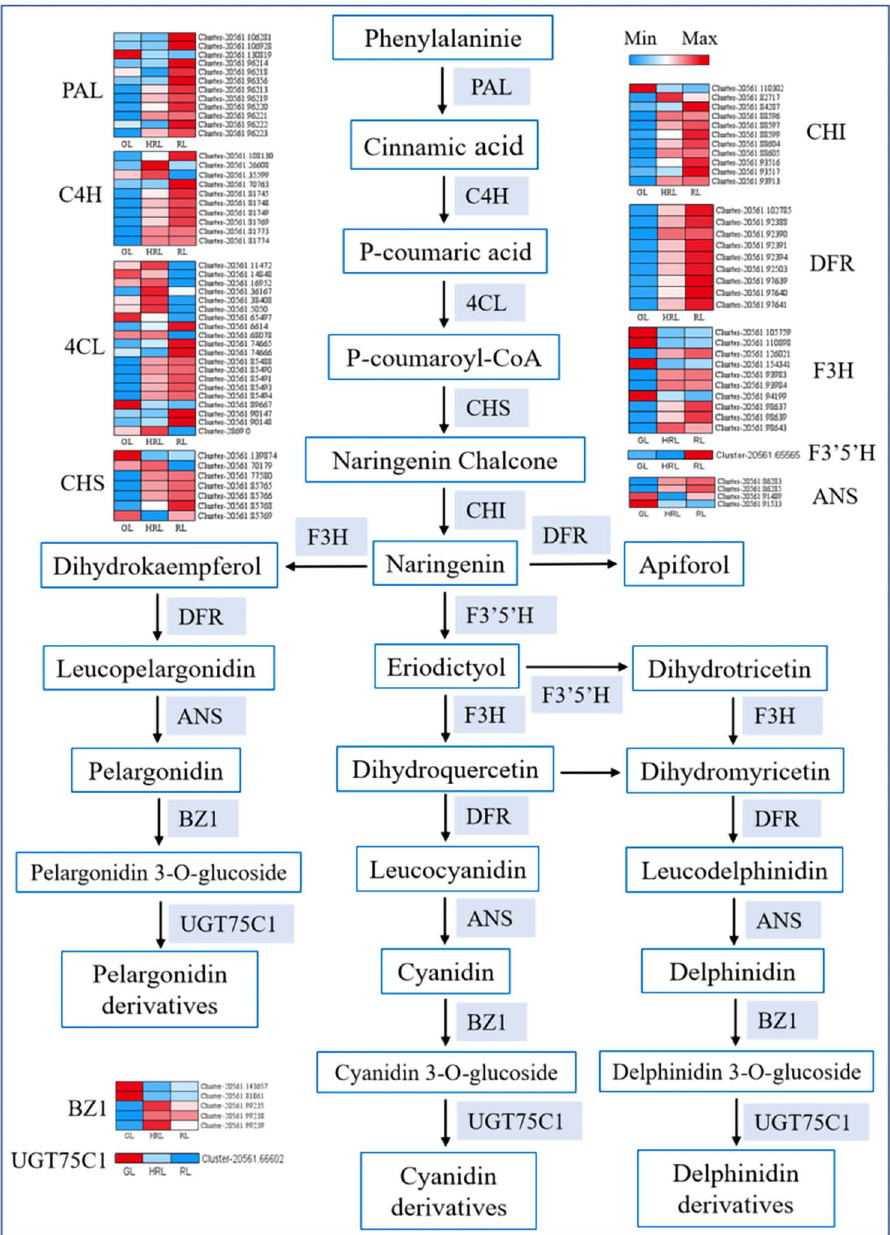
Figure 6. Modulation of phenylpropanoid, flavonoid, and anthocyanidin biosynthesis pathway genes during leaf color change in A. mandshuricum . Reconstruction of the phenylpropanoid, flavonoid and